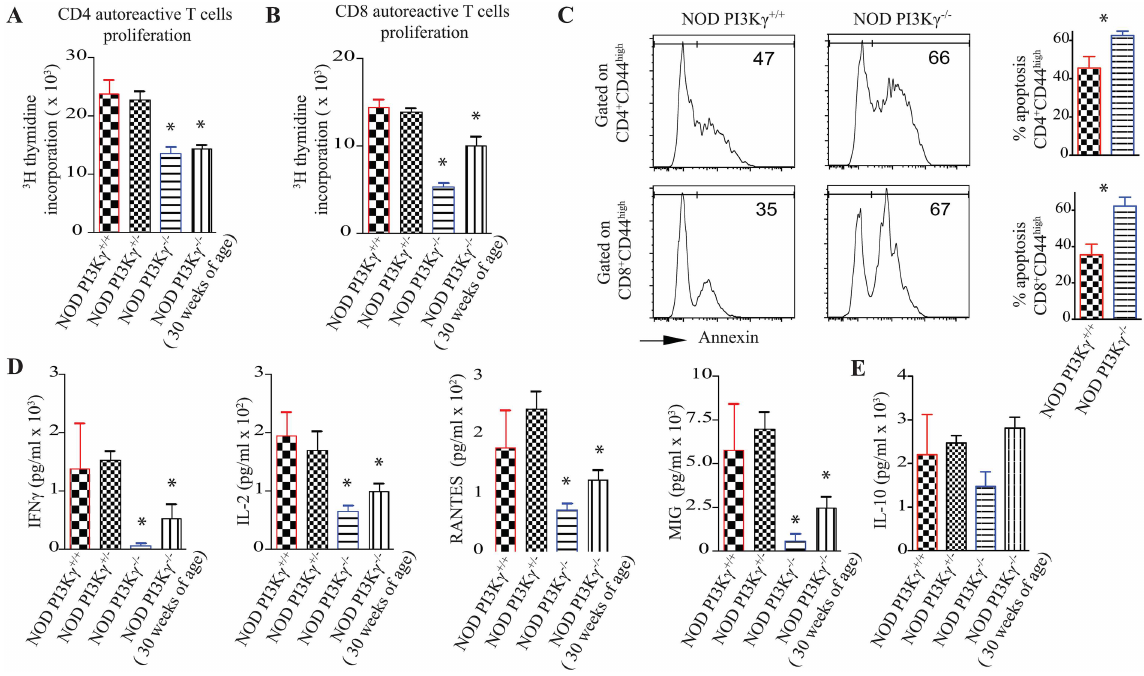
Fig 3. PI3K γ -deficiency impairs autoreactive-T-cells activation and survival upon stimulation with pancreatic-peptides. (A) Graph representsautoreactive CD4 T-cell proliferation for 48 hours as measuredby thymidineincorporation. Splenocytes recovered from NOD.PI3K γ +/+ , NOD.PI3K γ +/- , NOD.PI3K γ -/- at 12-weeksof age and NOD.PI3K γ -/- at 30-weekswere stimulated ex-vivo with BDC2.5 pancreaticpeptide. (B) Graph representsautoreactive CD8 T-cell proliferation as measuredby